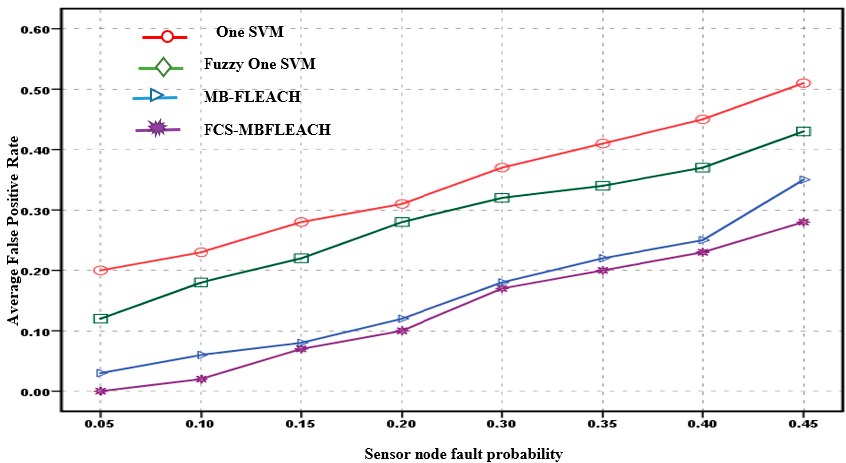
Figure 14. Average false positive rate for sensor node faults with a density equal to 10 for the second scenario.